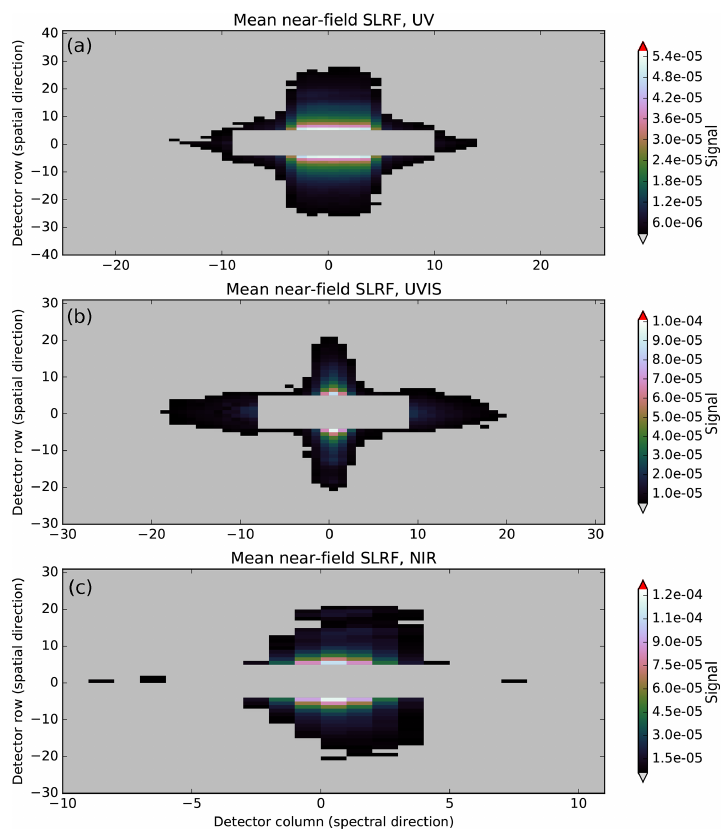
Figure 24. Mean near-field straylight response function, shown for the UV (a) , UVIS (b) , and NIR (c) spectrometers. Each response function is displayed as a two-dimensional pseudo-colour plot, as a function of the relative distance in the spectral and spatial directions. The unit for the straylight response function is 1. The rectangle in the centre is the excluded direct region. The direct region in the spatial direction is 9 pixels wide for all UVN spectrometers; the width in the spectral dimension is optimized for each spectrometer to match the instrument spectral response function